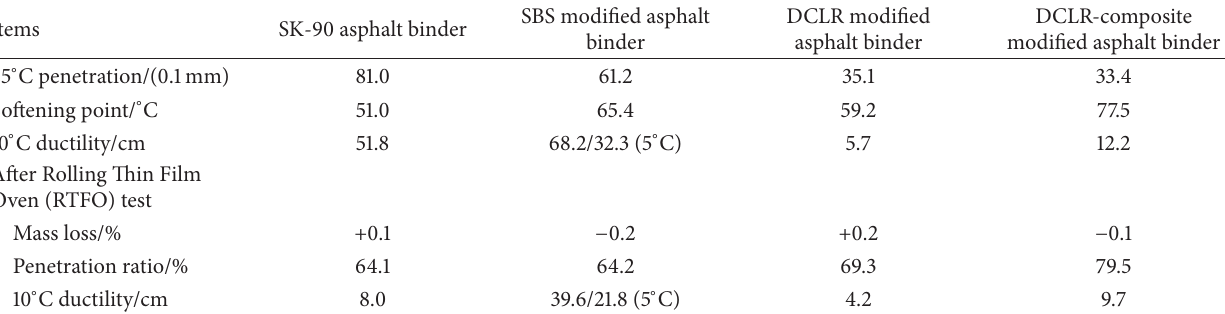
Table 2: Properties of the asphalt binders (penetration